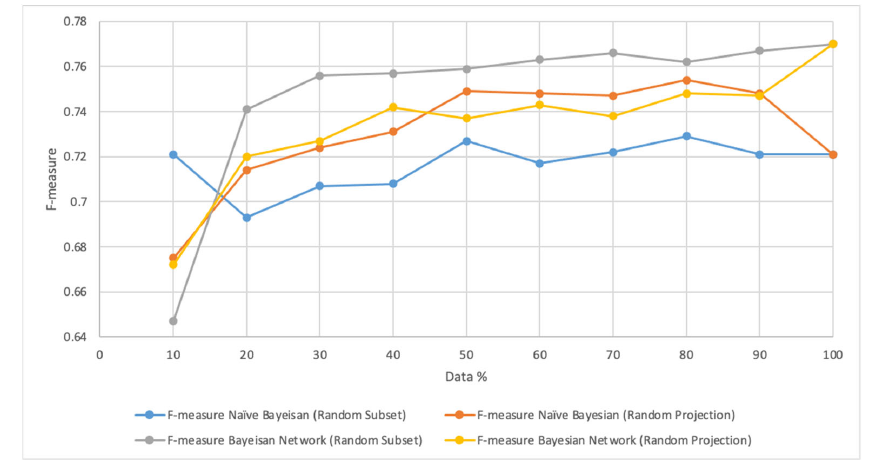
Figure 10. Overall F ‐ measure with data samples for the four combinations.